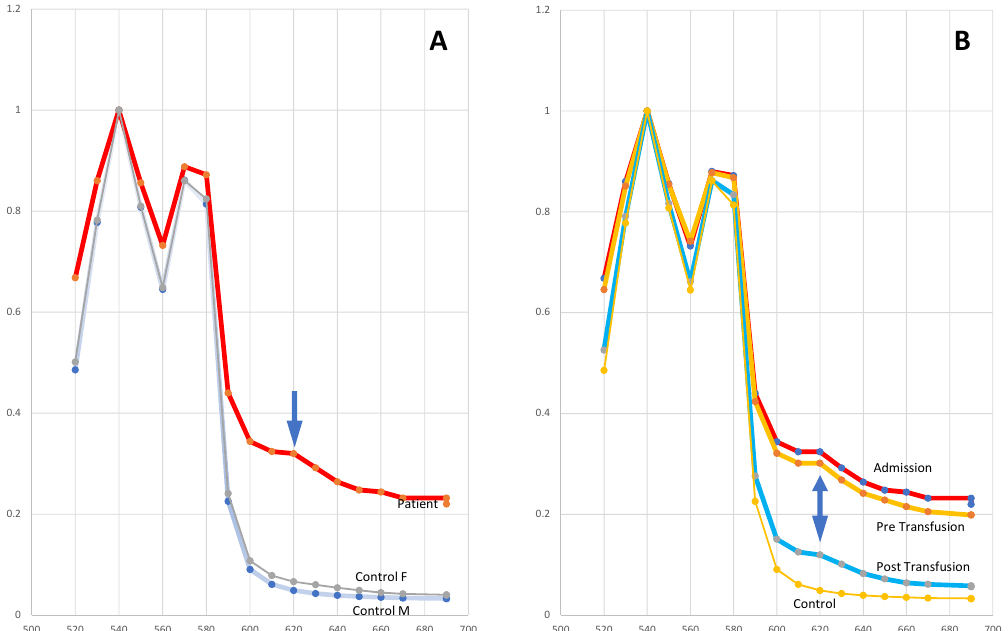
Figure 3. Absorption spectra of hemoglobin samples. Panel ( A ): the patient and a female (F) and male (M) control sample; the arrow marks an increased absorption peak at 620 nm. Panel ( B ): the patient’s sample on admission, pre-transfusion, and post-transfusion compared to the control sample; the double arrow marks the absorption peak at 620 nm seen in all patient samples.